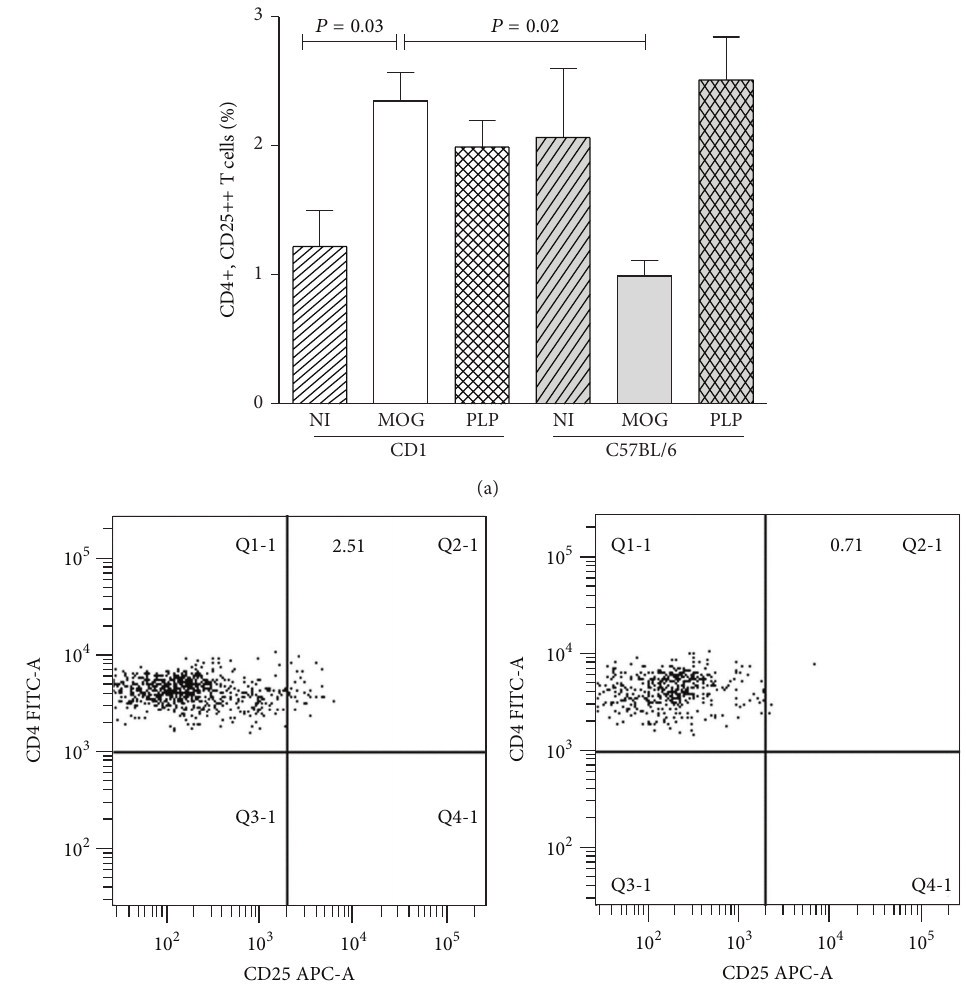
Figure 3: Regulatory T cells in spleens of resistant and susceptible mice. We analyzed these cells in series of seven mice per condition. (a) We studied nonimmunized mice (NI) and mice immunized with MOG 35−55 (MOG) and with PLP 139−151 (PLP). CD1 mice upregulated CD4+CD25 hi T cells when immunized with MOG or PLP autopeptides. Conversely, Treg percentages did not increase in C57BL/6 mice immunized with MOG that developed EAE. (b) Representative dot plots showing regulatory T cells induced in CD1 (left side) and C57BL/6 (right side) mice upon immunization with MOG 35−55